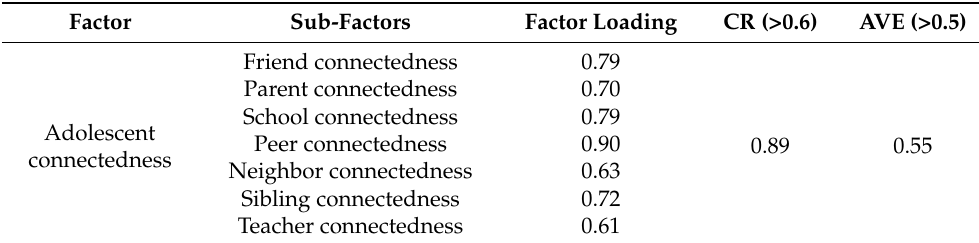
Table 4. Average Variance Extracted (AVE) and Composite Reliability (CR).